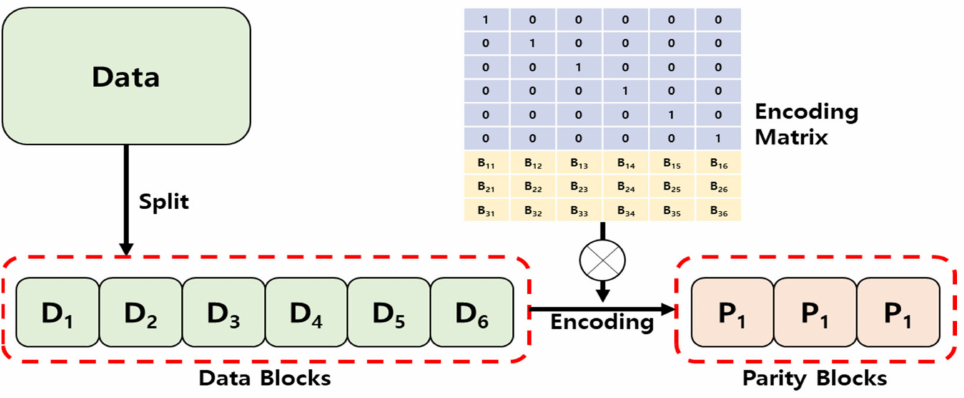
Figure 1. Encoding process of erasure